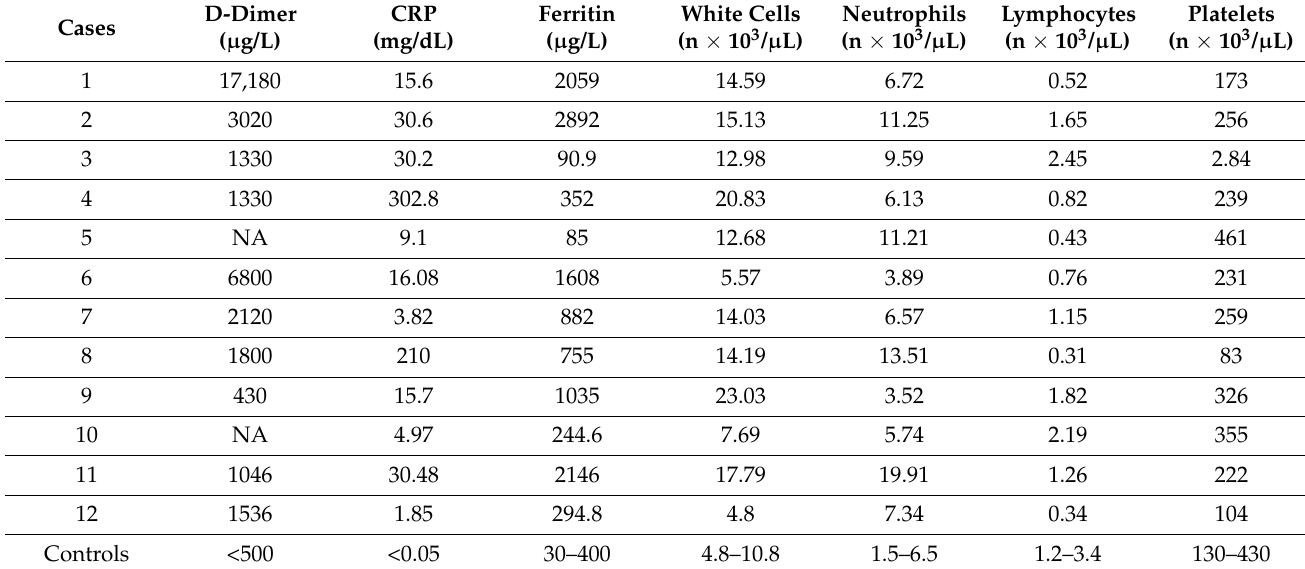
Table 2. Laboratory findings before